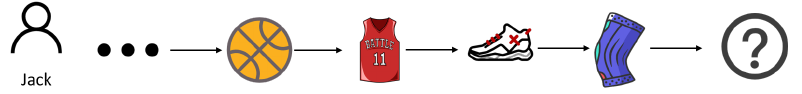
Figure 3. An illustration of the interaction sequence of a user with